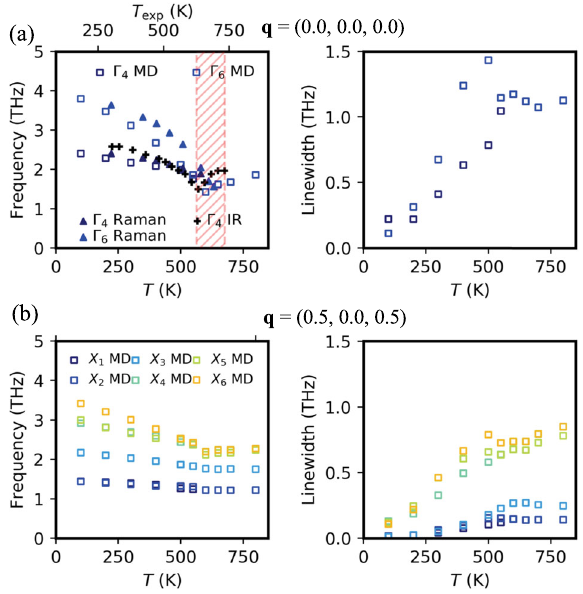
Fig. soft-modes behavior. Temperature- dependent phonon frequencies and linewidths of GeTe obtained from MD simulations at q -vectors of ( a ) (0.0, 0.0, 0.0) and ( b ) (0.5,